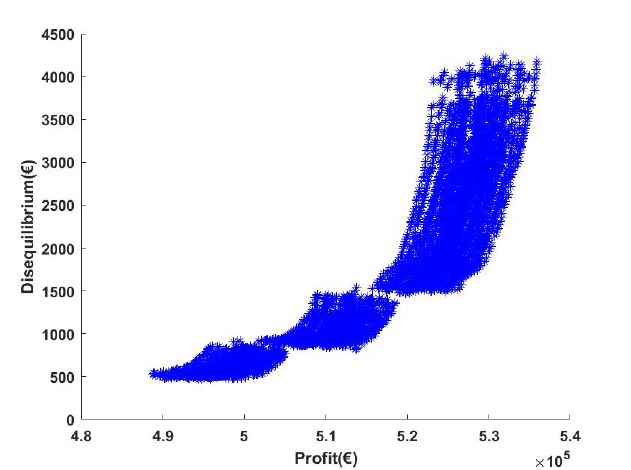
Figure 18. Pareto fronts in Monte Carlo